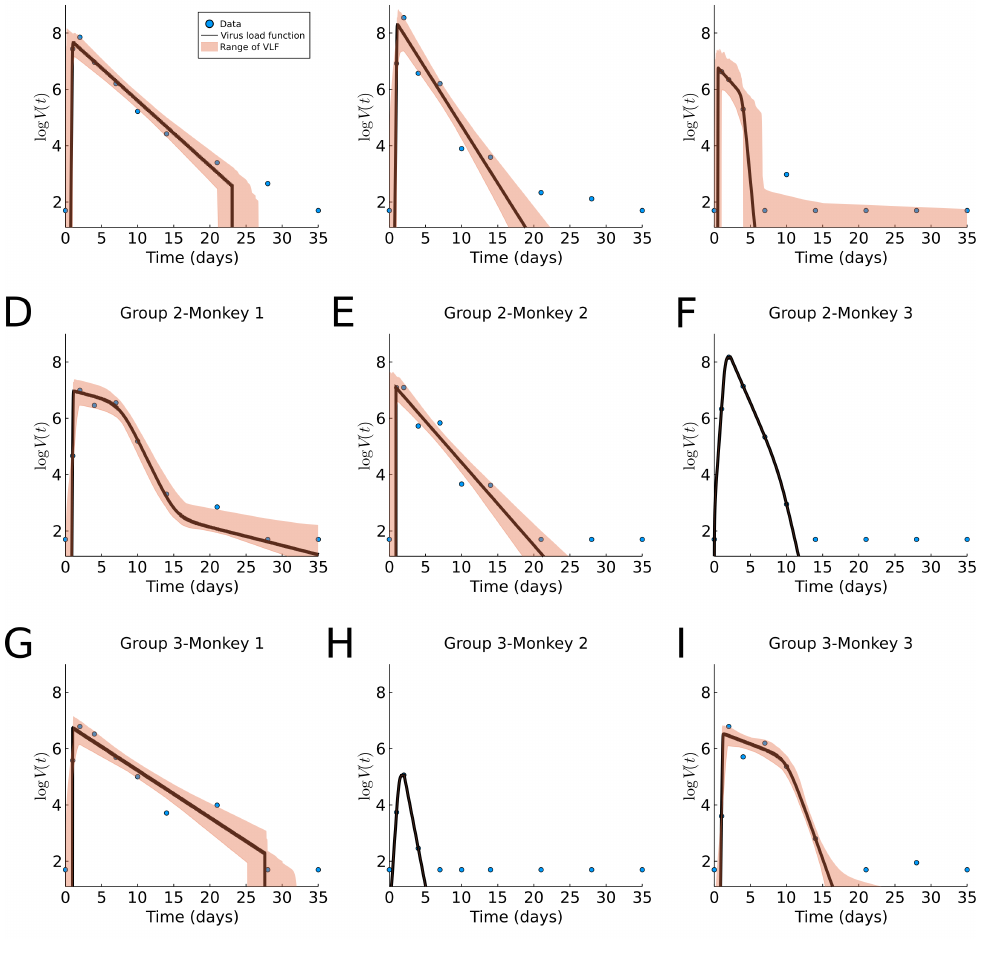
Figure 8. Fitting results of the virus load function (1) to macaque monkey SARS-CoV-2 data [6]. The area in red represent the likelihood range of virus load functions. ( A – I ) Groups 1, 2, and 3, Monkeys 1, 2, and 3,